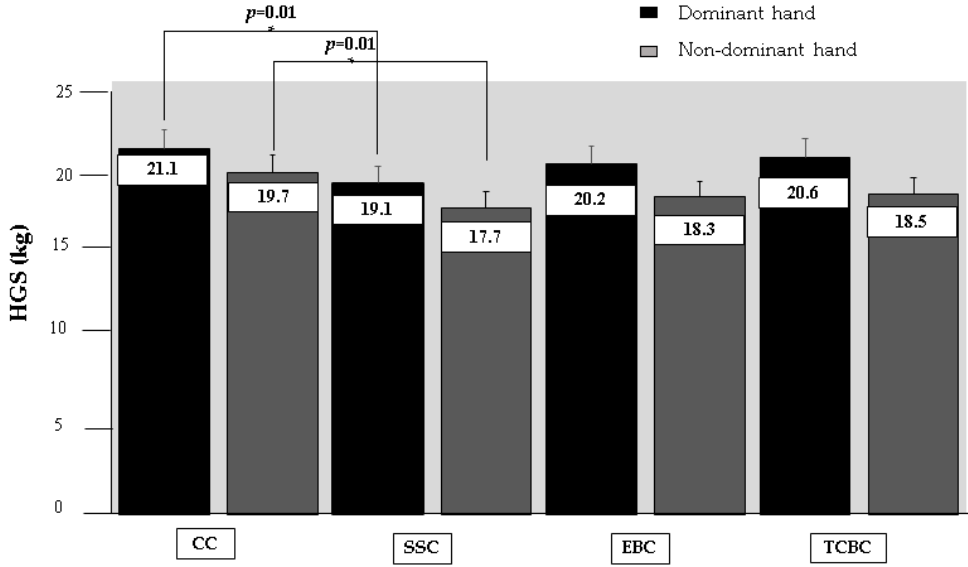
Figure 3. Graphical differences between intervention conditions on handgrip strength. Legends: HGS: handgrip strength. CC: control condition, no warm ‐ up. SSC: static stretching condition, static flexibility exercises. EBC: elastic band condition, muscle strength exercise. TCBC: therapeutic compression ball condition: muscle strength exercise. *: statistically significant differences between conditions.